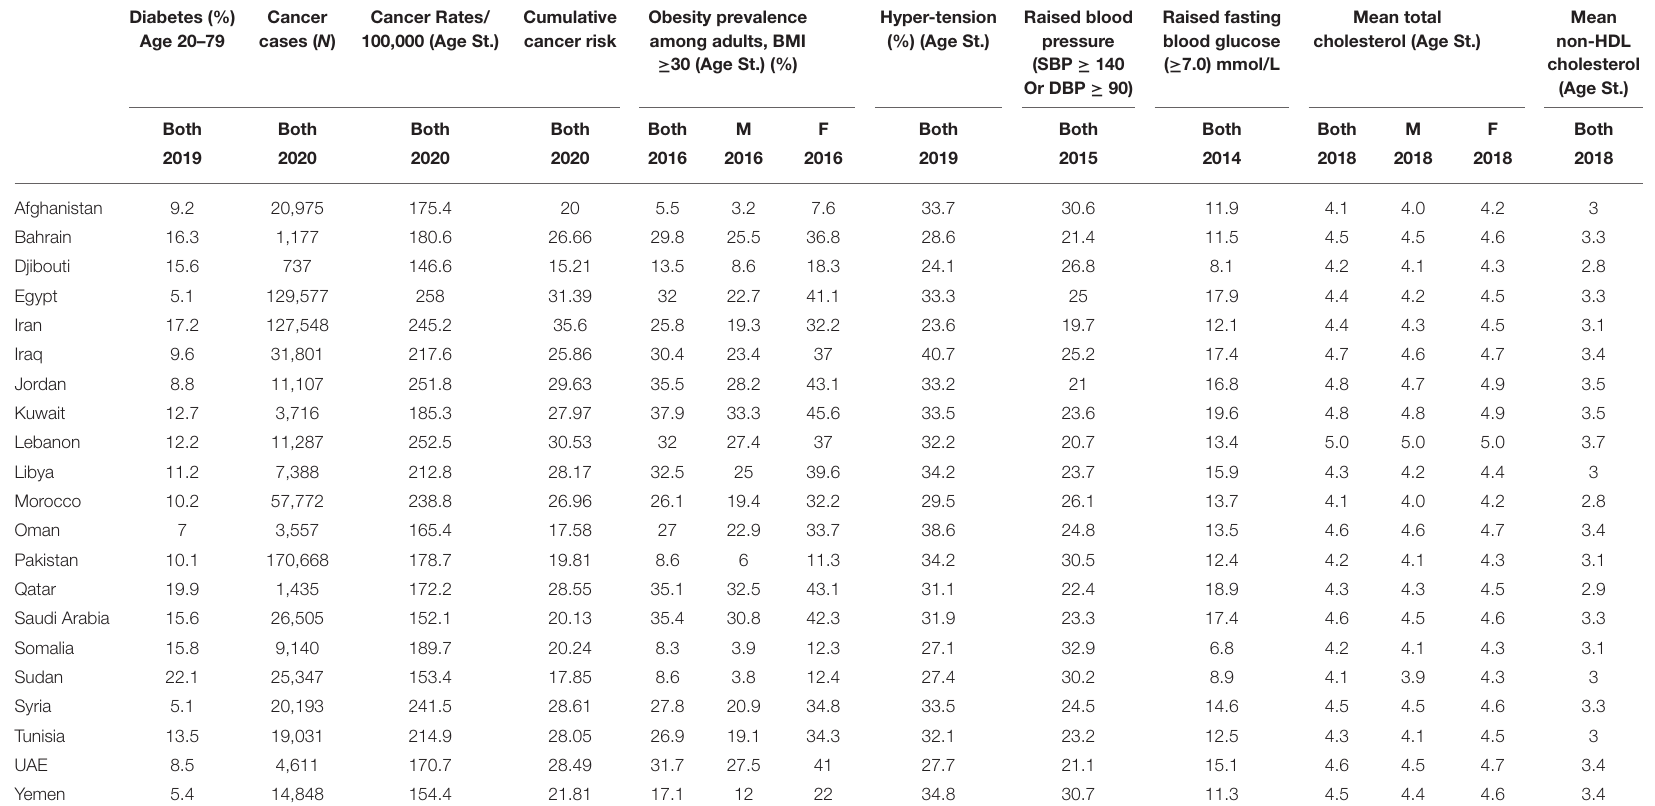
TABLE 2 | Obesity, raised fasting blood glucose, raised blood pressure, diabetes prevalence, and cancer trends in EMR